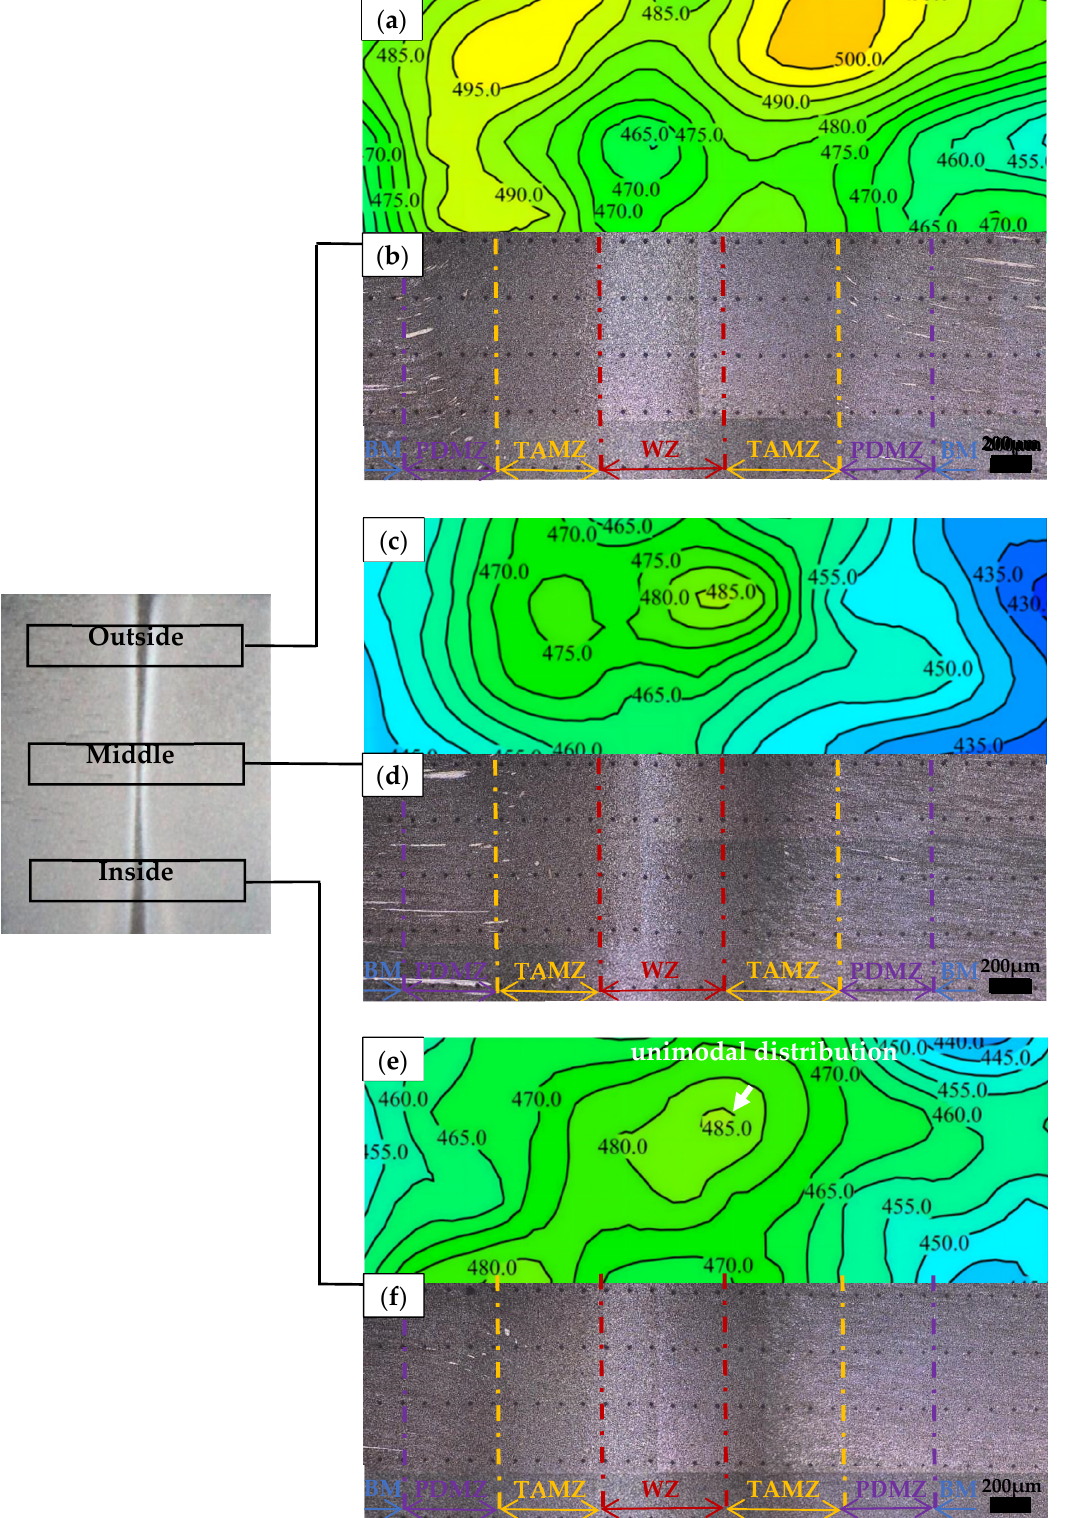
Figure 7. Microhardness distribution in different zones of GH4065A alloy IFW joints. ( a , b ) Outside contour map and microstructure map, ( c , d ) Middle contour map and microstructure maps, ( e , f ) Inside contour map and microstructure maps.